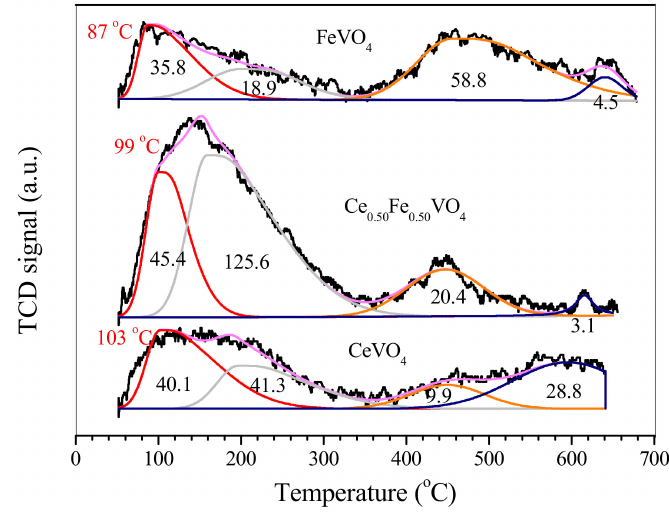
Figure 11. NH 3 -TPD profiles of the